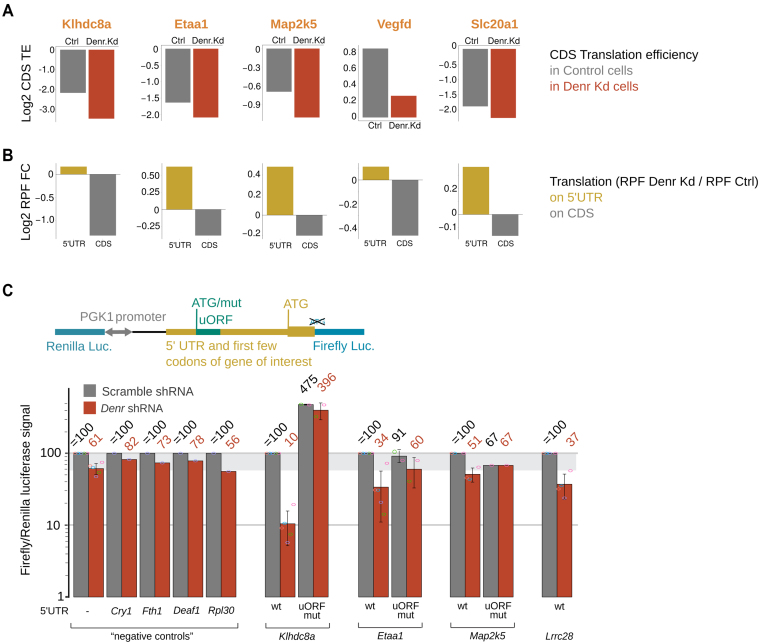
Mutation of uORF start codons relieves DENR dependence. (A) Representative examples of genes with differential TE. Panels show average CDS translation efficiency in control (grey) and Denr Kd (red) cells. (B) Denr Kd-to-control translation on the 5′ UTR (brown) and on the CDS (grey) for the same examples as in (A). DENR targets showed decreased CDS TE (A) and increased 5′ UTR translation concomitant with reduced CDS translation in Denr-deficient cells. (C) (Upper) Schematic representation of the dual luciferase reporter construct, where the 5′ UTR of the gene of interest—with the WT or mutated uORF start—and first few codons of the CDS were cloned upstream of firefly luciferase (FL). (Lower) Results of dual luciferase assays, where the influence of the 5′ UTR (WT and uORF mutant) on the expression of FL was measured in control and Denr knockdown cells, and internally normalized to RL (expressed from the same bidirectional promoter). Note that for all targets tested, depletion of Denr reduced the FL/RL luciferase signal, indicating DENR-dependence of reporter protein expression. Mutation of uORF start codons relieved the inhibition and partially abolished DENR-dependence. For each 5′ UTR assayed, FL/RL signals were normalized to the Scr-transduced non-mutated construct. The area of grey shading marks the non-specific effect of Denr loss-of-function in this assay, as judged from the reduction in signal seen for negative control reporters that contained no cloned 5′ UTR (-) or irrelevant 5′ UTRs selected from non-targets.